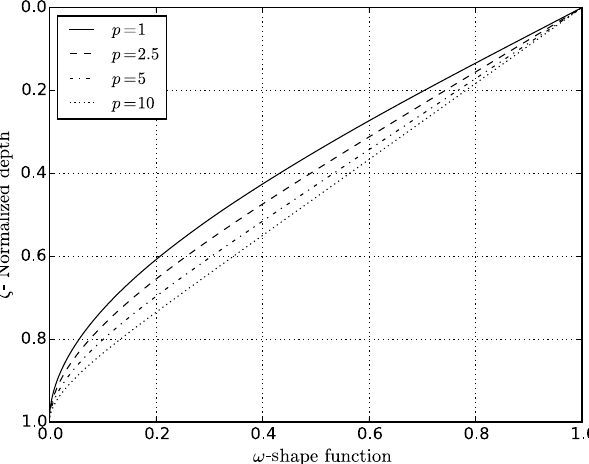
Figure 3. Shape function ω(ζ) for several values of shape parame- ter p (no basal